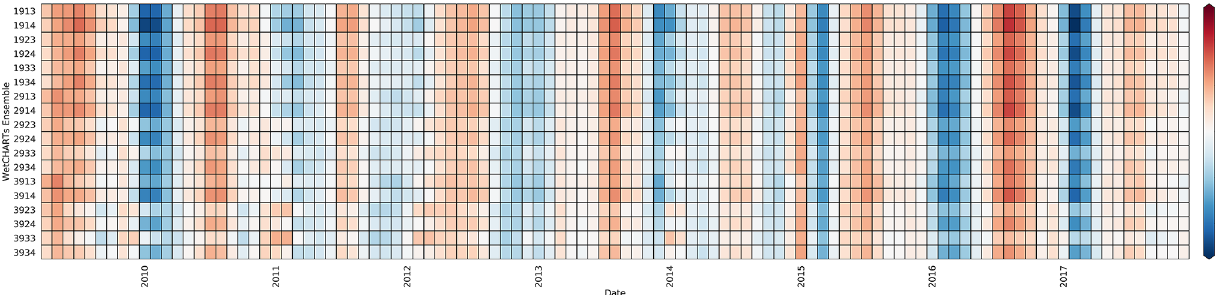
Figure 8. Modelled – GOSAT monthly mean wetland CH 4 seasonal-cycle differences for all WetCHARTs ensemble members from 2009 to 2017 over the Paraná region.